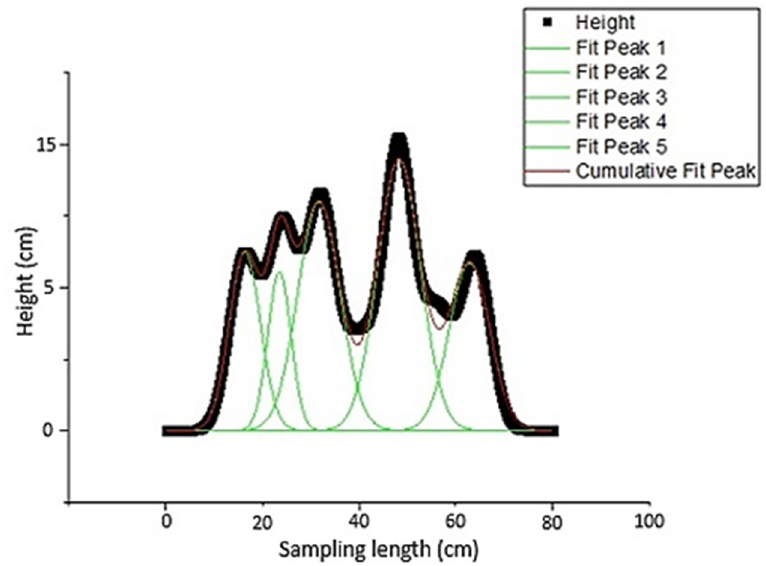
Figure 11. Corresponding peak fitting for the two irregular plow layers based on height profile.